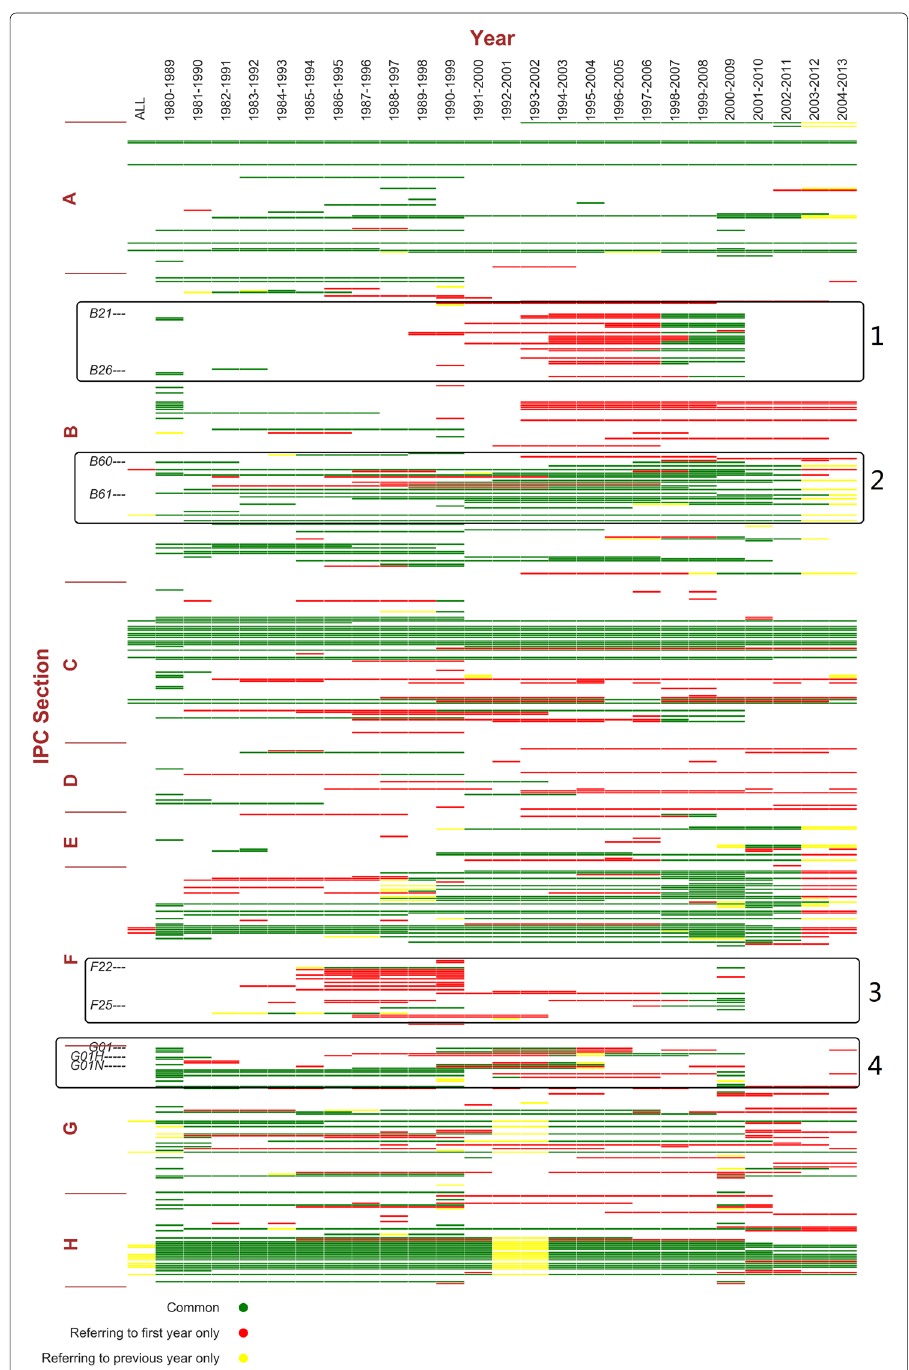
Fig. 4 Central nodes of 10-year time window rolling from year to year. The x-axis indicates time windows from 1980–1989 to 2004–2013, except for the first column labeled “ALL”, which is the all-year condition. The y-axis indicates the nodes, i.e. IPC subclasses, ordered in IPC index. Colored blocks indicate central nodes in a time window using at least one referencing method: Green represents central nodes both methods have in common, red for those central only by referring to the initial year, and yellow for those central only by referring to the previous